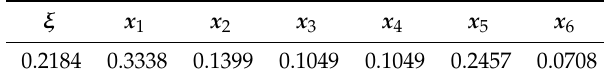
Table 8. The results of the optimization problem in Equation